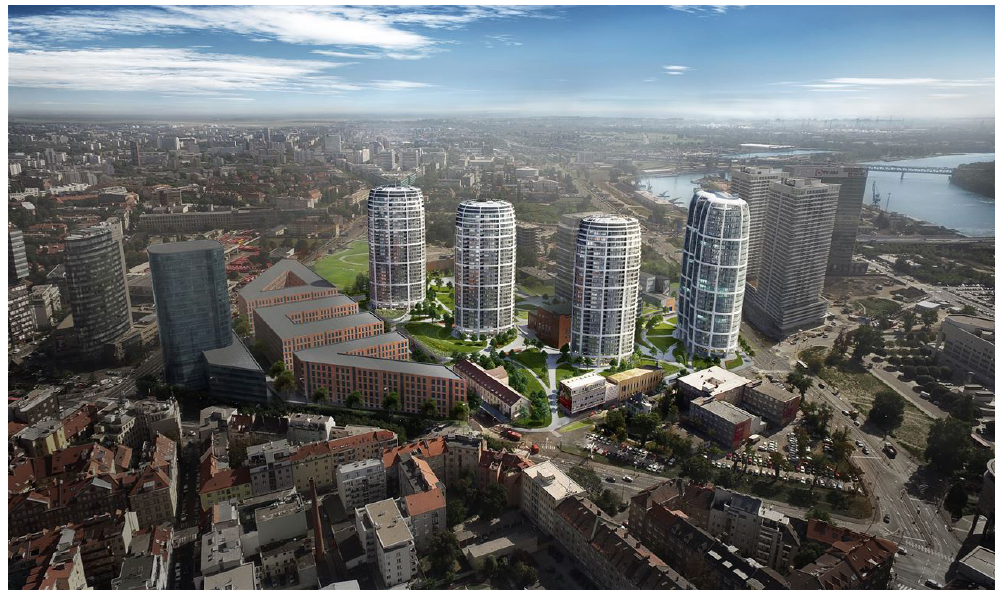
Figure 2. Visualisation of the Sky Park project. Source: Penta Investments